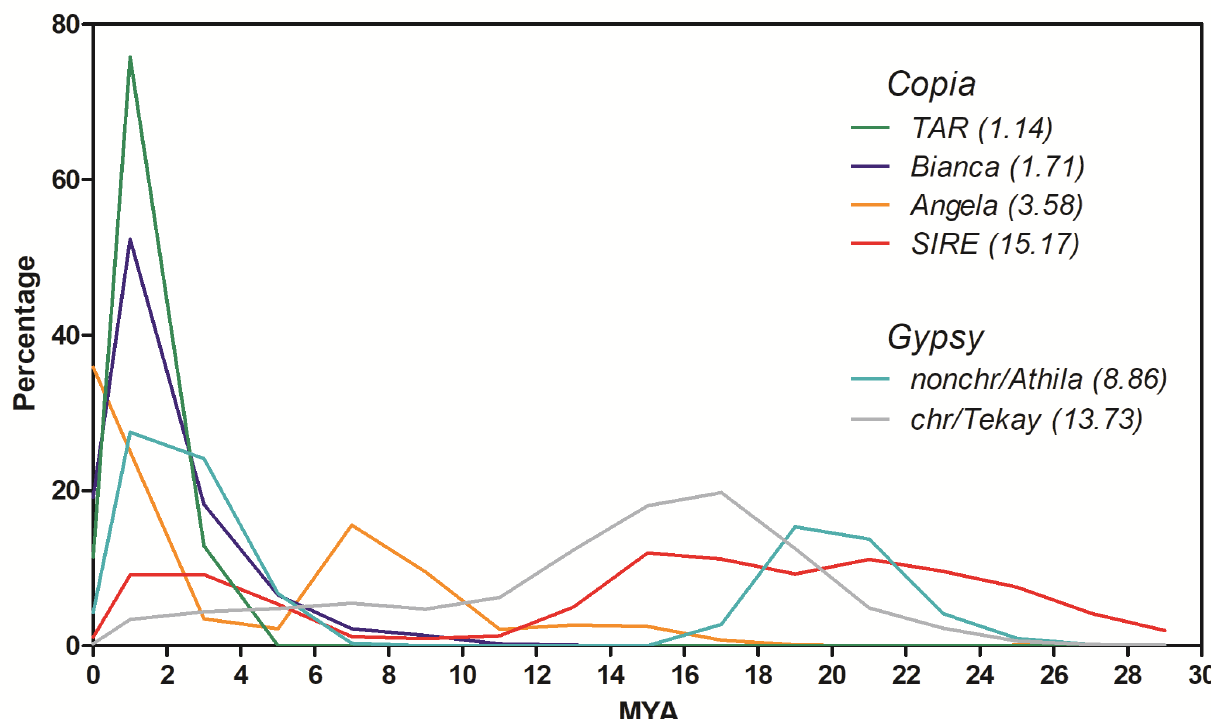
Figure 4. Timing of retrotranspositional activity of four Copia and two Gypsy lineages of S. rebaudiana based on pairwise comparisons of Illumina reads that match RT encoding sequences. The average insertion time (in MYA) for each lineage is reported in parentheses. MYA, million years ago; chr, Chromovirus ; nonchr, non- Chromovirus .